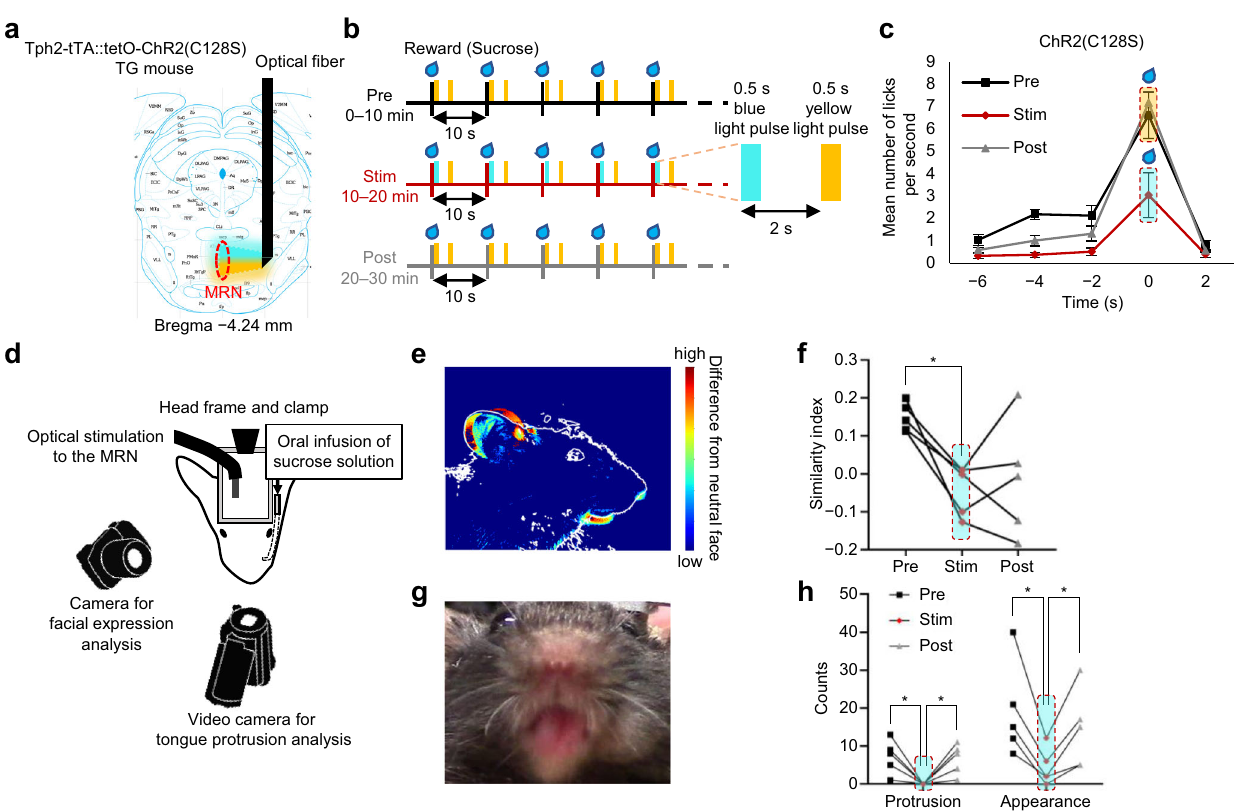
Fig. 4 | Effect with activation of MRN serotonergic neurons on reward con- sumption and facial expression in Tph2-tTA::tetO-ChR2(C128S) bigenic mice. a Schematic representation of fi ber implantation and distance from the bregma. b Schematicdiagramoftheoptogeneticstimulationduringthe fi xed-timeschedule task.A2 μ Ldropof10%sucrosesolutionrewardwasdeliveredevery10s. c Number of licks during each phase of the fi xed-time schedule task (Black: Pre, Red: Stim, Gray: Post). Each time point of the graph represents the mean number of licks for 2s. A 2-way ANOVA for repeated measures revealed a signi fi cant interaction effect of Phase×Time ( F 8,32 =5.37, P =0.0003). Multiple comparisons at each time point revealed a signi fi cant Pre vs Stim phase effect in Time − 4s ( P =0.0059) and − 2s ( P =0.015), and 0s ( P =5.76×10 − 7 ). Stim vs Post phase effect was also observed in Time0s( P =3.25×10 − 8 ). d SchematicrepresentationoforalinfusionsetupinTph2-